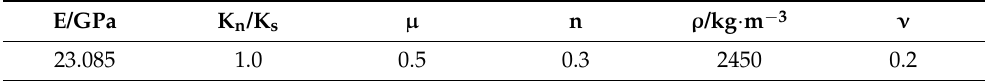
Figure 12. Failure evolution process of the specimen. Table 11. Main meso-parameters involved in PFC 3D numerical